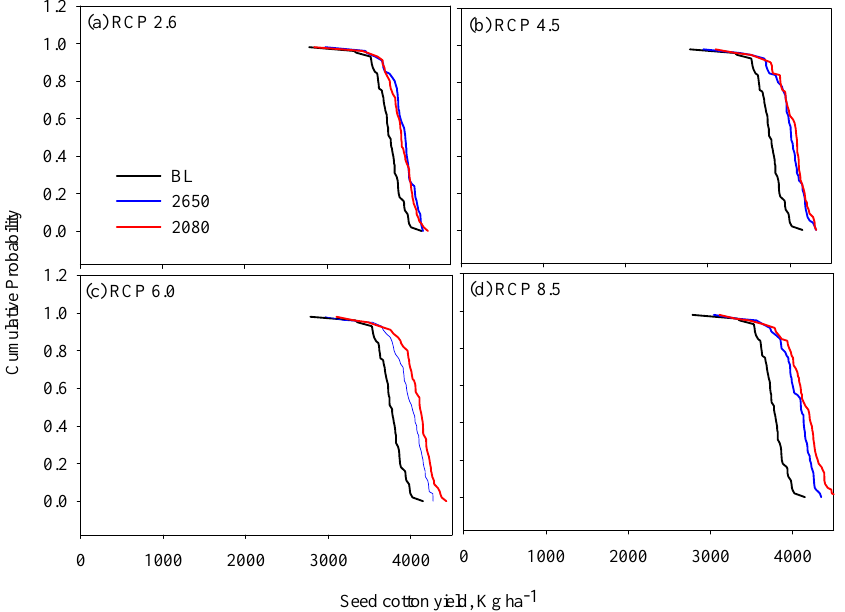
Figure 6. Simulated impacts of CO 2 concentration in the air alone, under RCP 2.6 ( a ), 4.5 ( b ), 6.0 ( c ), and 8.5 ( d ) greenhouse gas (GHG) emission scenarios on irrigated seed cotton yield in 2050 and 2080. The projected temperature and rainfall changes were not considered.